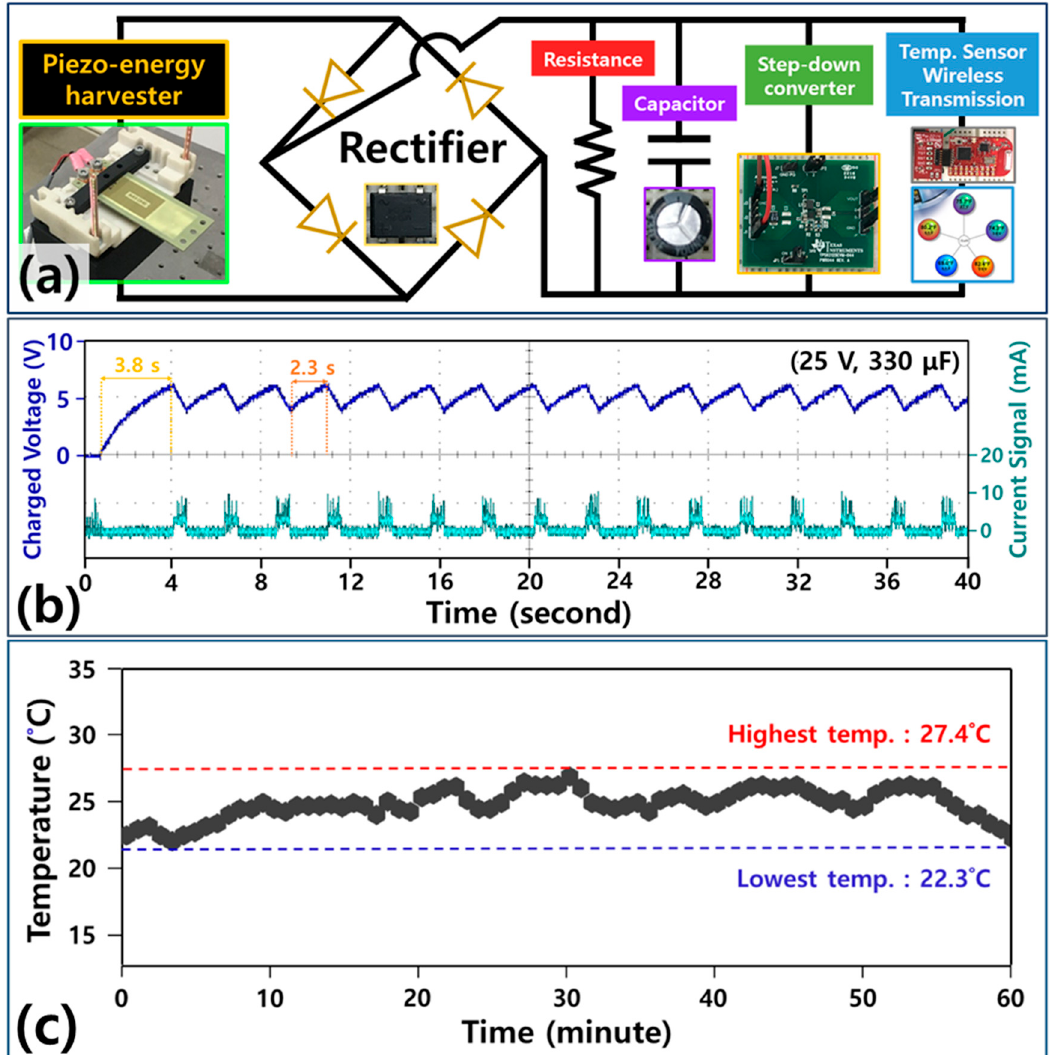
Figure 7. ( a ) Electrical circuit for powering the wireless sensor and data transmission system utilizing the magnetic field generated from the power-line cable of the power plant. ( b ) Graph of the current drawn from power-line cable of the power plant, charged to 330 μ F through the harvester, and measured the temperature data obtained using the charged energy. ( c ) Graph measured from the ambient temperature of the power-line cable ranging from 22.3 to 27.4.